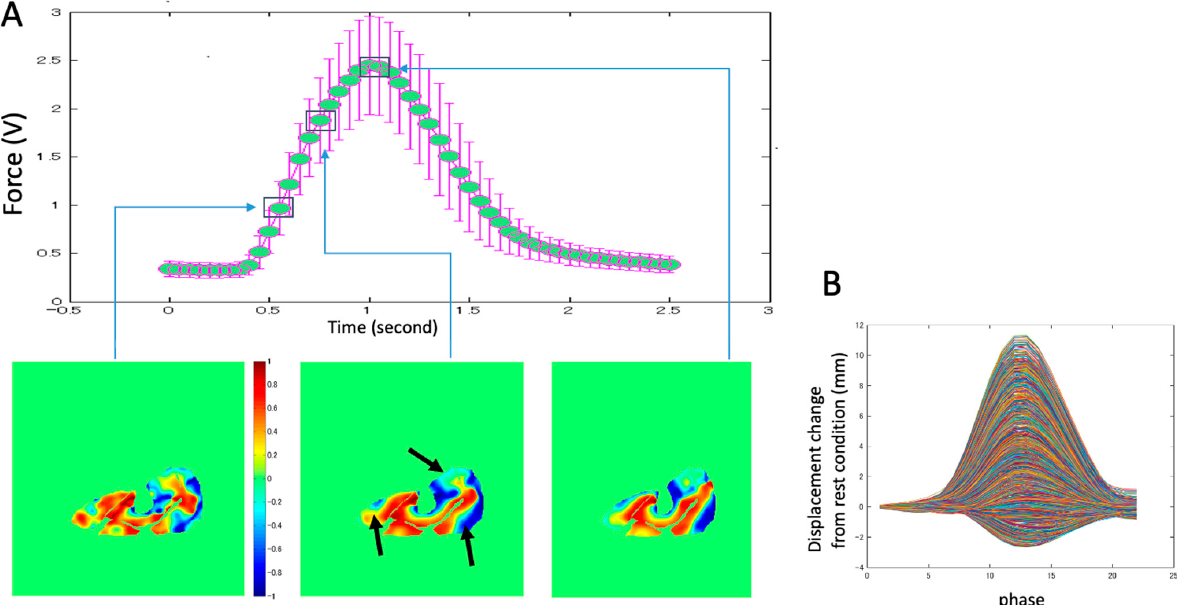
Figure 9. ( A ) Example of temporal variation of the ratio of the Z-component displacement vector to the total displacement. The bottom figures demonstrate the distribution of the ratio of the Z -axis displacement and the total displacement of the three phases during contraction. The values near 1 or − 1 imply that the Z -axis (out-of-plane) displacement is larger than the in-plane displacement. The positive values are from the distal to the proximal, and the negative values are from the proximal to the distal. ( B ) The temporal variation of the distribution change in the Z-component displacement vector for all voxels in the same trial is shown in Figure 9A. Most pixels demonstrate a positive increment and decrement, while some pixels show small negative values.